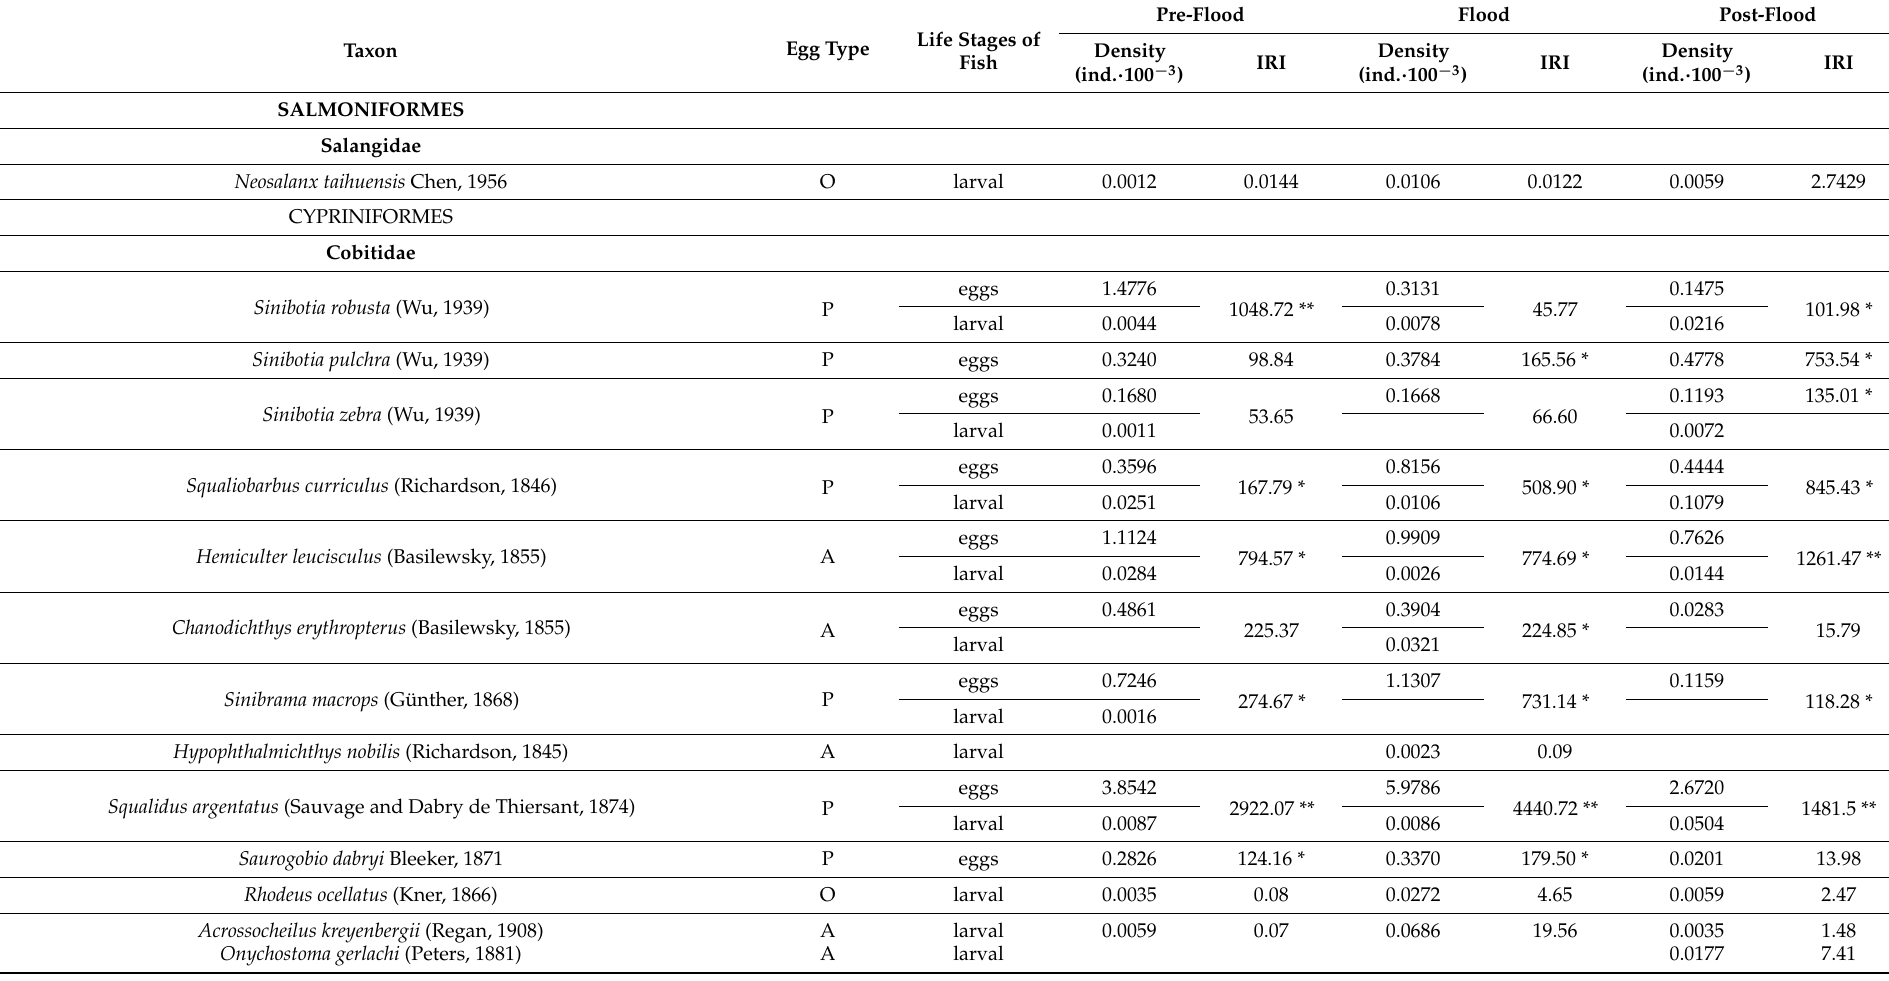
Table 2. Species composition and mean density (no. of larvae per 100 m 3 ) of the ichthyoplankton collected in the upper Xijiang in the summer of